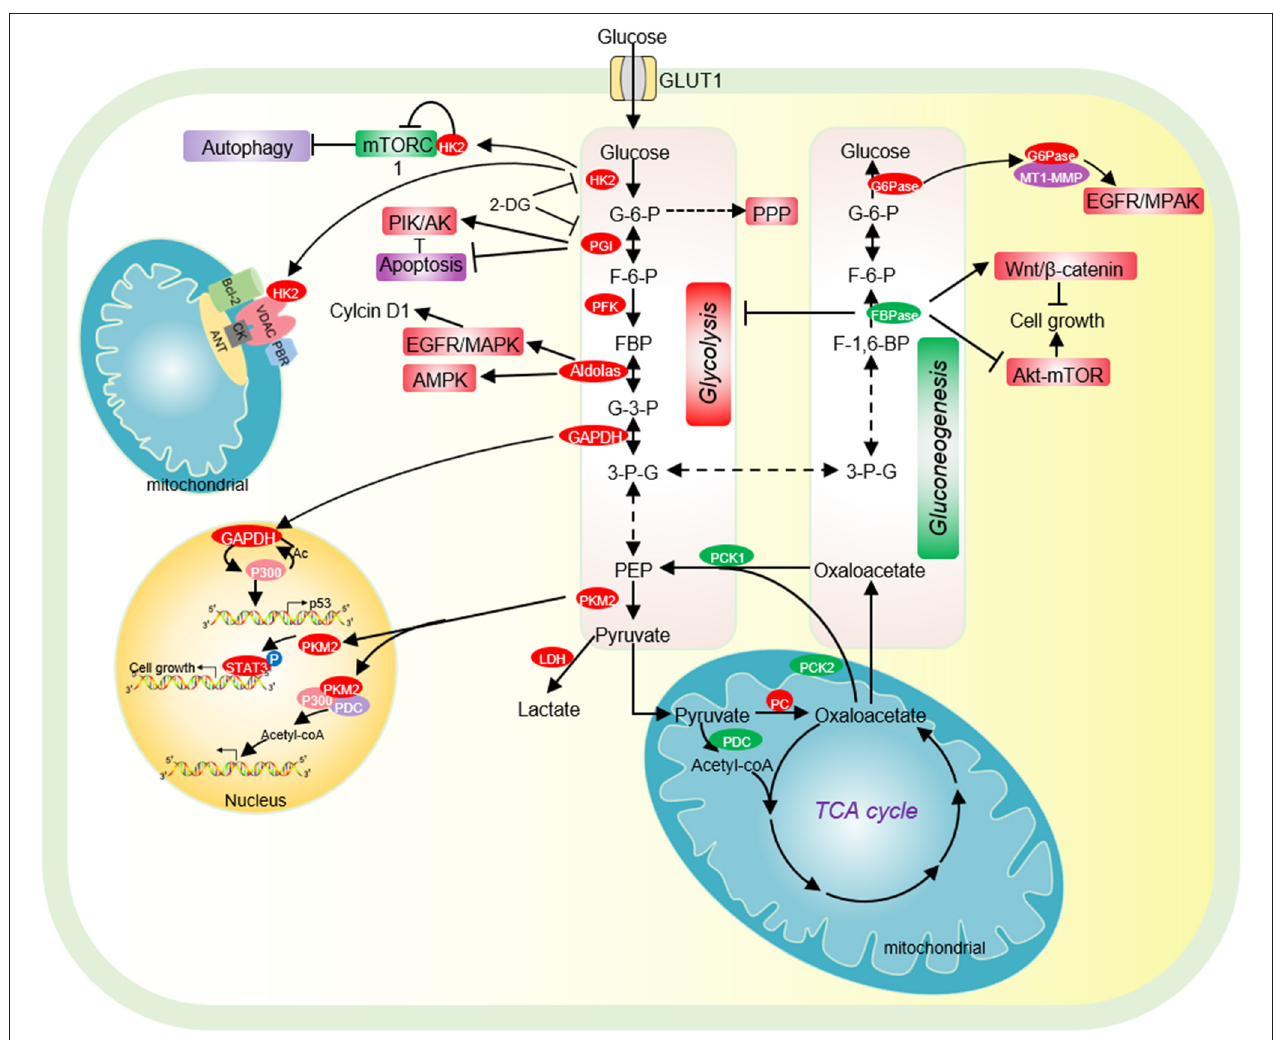
FIGURE 1 | The effect of glycolysis and gluconeogenesis on tumor cell proliferation. Cancer cells have increased glucose uptake, leading to accelerated glycolysis and biomass accumulation. The high expression of GLUT1, HK2, PGI, PFK, Aldolase, GAPDH, and PKM2 significantly accelerates aerobic glycolysis. Increased lactate dehydrogenase (LDH) activity and decreased pyruvate dehydrogenase (PDC) activity result in increased lactate export, attenuated TCA cycle and diversion of glycolysis to pentose phosphate pathway (PPP). HK2 not only directly binds to mTORC1 to activate autophagy, but also interacts with VDAC to protect tumor cells from apoptosis. PGI inhibits cell apoptosis by inhibiting the expression of Apaf-1 and caspase-9 and activating the PI3K/Akt signaling pathway. Acetylated nuclear GAPDH promotes tumorigenesis by activating p300 and promoting p53 expression. Aldolase promotes cell cycle progression through the EGFR/MAPK signaling pathway, and activates AMPK to maintain tumor cell survival in glucose deficiency. Nuclear PKM2 performs a variety of non-metabolic functions to promote cell cycle progression. Low expression of pyruvate carboxylase (PC), the key enzyme of gluconeogenesis, is essential for the proliferation of some cancer cells. PC is essential for the synthesis of fatty acid and glycerol in cancer cells. The low expression of the key enzyme PEPCK of gluconeogenesis is beneficial for the proliferation of cancer cells. FBPase acts as a tumor suppressor and inhibits the proliferation of tumor cells. G6PT promotes the invasion of glioblastoma by interacting with MT1-MMP. HK2, hexokinase 2; G-6-P, glucose-6-phosphate; PGI, phosphoglucose isomerase; F-6-P, fructose-6-phosphate; FBP, fructose-1,6-biphosphate; G-3-P, glyceraldehyde-3-phosphate; 3-P-G, 3-phosphoglycerate; GAPDH, Glyceraldehyde-3-phosphate dehydrogenase; PKM2, Pyruvate kinase M2; LDH,